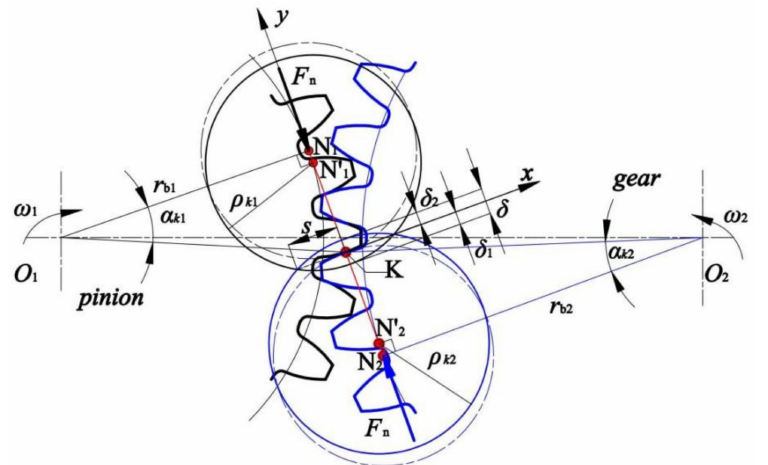
Figure 3. Tooth surface contact